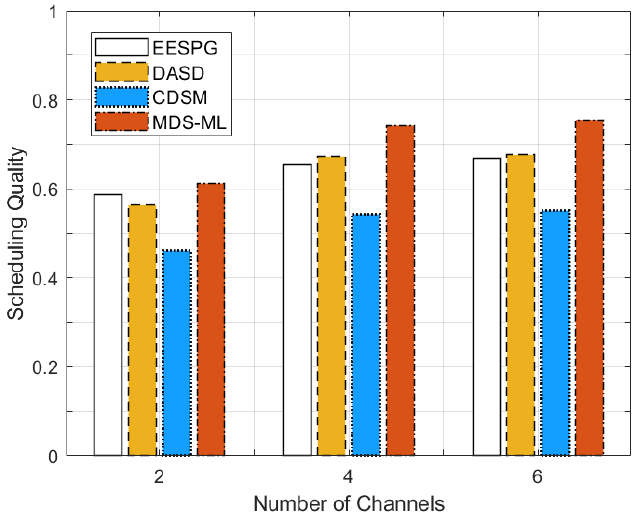
Figure 11. Comparison of scheduling quality with different number of